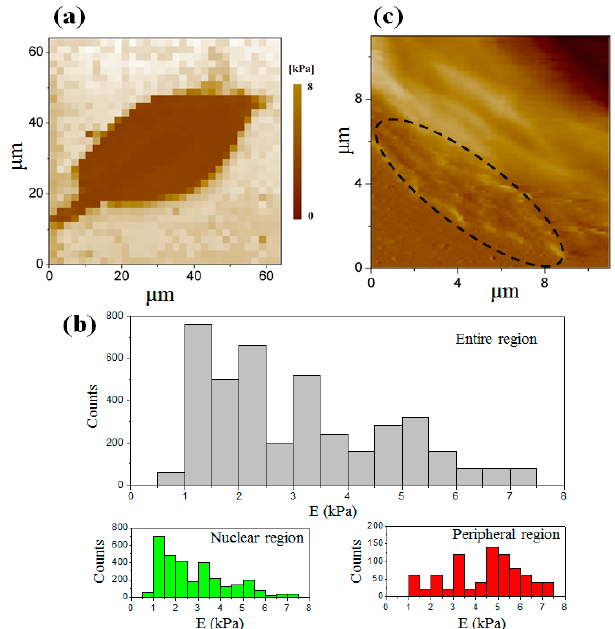
Figure 4. ( a ) The elastic modulus map of a single cell at the interphase with the resolution of 32 × 32 data points; ( b ) the histogram of the elastic modulus distribution in the whole region (gray), in the nuclear region (green), and in the peripheral region (red); ( c ) large lamellipodia area surrounded by black dashed ellipse in the peripheral